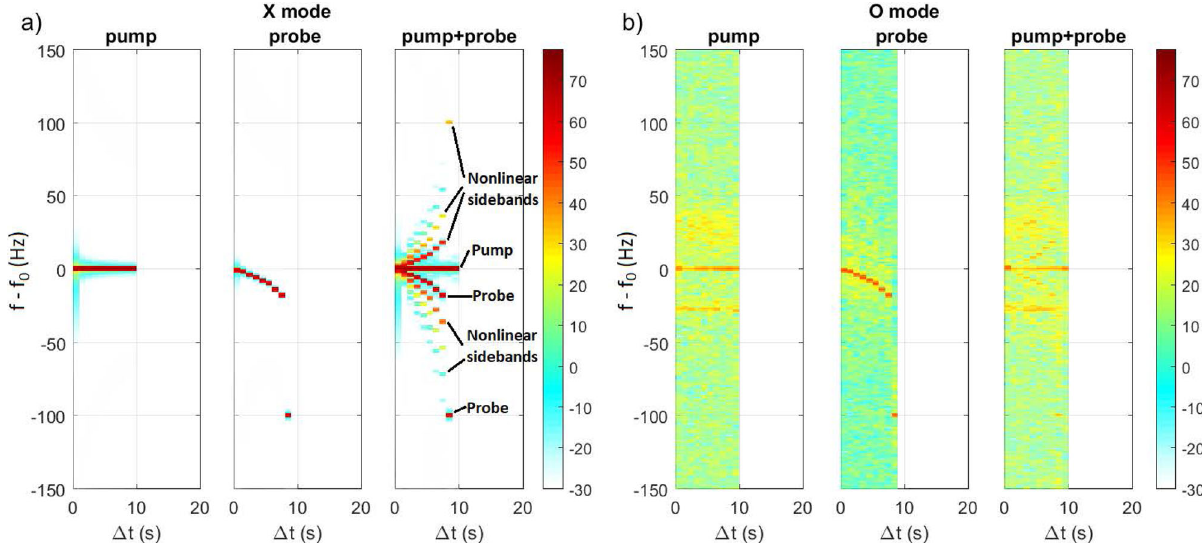
Fig. 7 Spectrograms obtained in full-wave simulations. One simulated cycle of a X mode and b O mode injected vertically. Each panel shows pump only with input amplitude 0.6 V/m and frequency f 0 ¼ 6 : 3 MHz, probe only with input amplitude 0.2 V/m, and frequency offsets relative to the pump given in Table 2, and both probe and pump. The latter shows a rich spectrum of nonlinear sidebands that escape the plasma as Fig. 7, to be compared to the experimental spectrograms in Fig. 2. The electric fi eld of the injected, upward propagating wave is eliminated from the data. For X mode polarization in Fig. 7a, the EM wave is re fl ected at z ¼ 211 : 68 km (cf. Figure 5a, c), below the altitudes for resonant coupling to Langmuir and upper hybrid waves. The pump and probe waves individually do not give rise to instability, and hence there are no visible nonlinear sidebands in the corresponding spectrograms. However, for the case of superimposed pump and probe waves, there is a rich spectrum of nonlinear sidebands with several down- and upshifted lines, similar to those of the experimental spectrograms in Fig. 2. The probe and pump waves generate an IA wave with